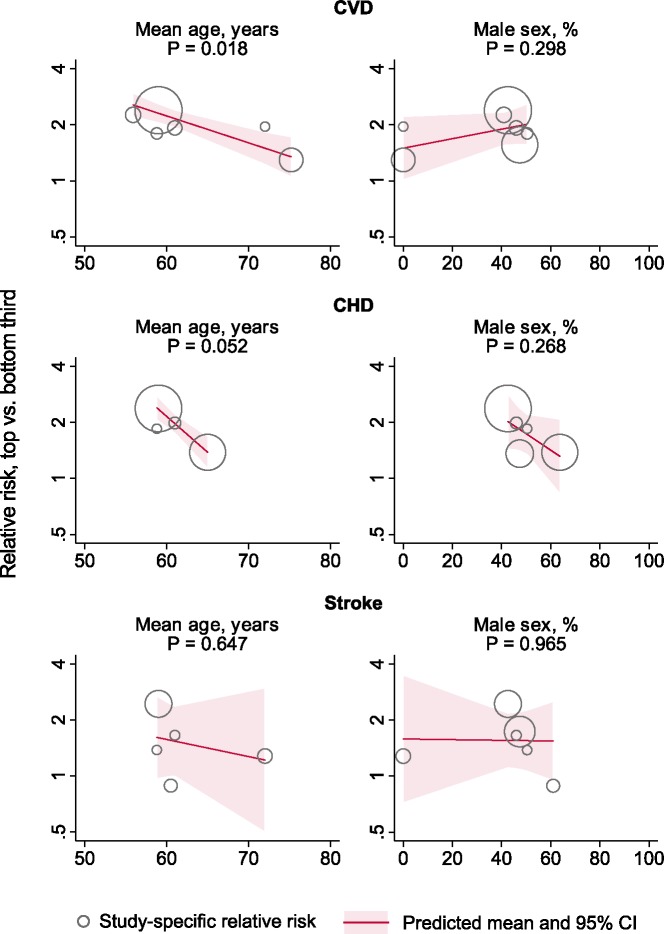
Relative risks for cardiovascular outcomes in the top vs bottom third of osteoprotegerin concentration according to average age and proportion of males in contributing studies.P values were derived from meta-regression. The marker size is proportionate to the inverse variance of the study-specific relative risk.